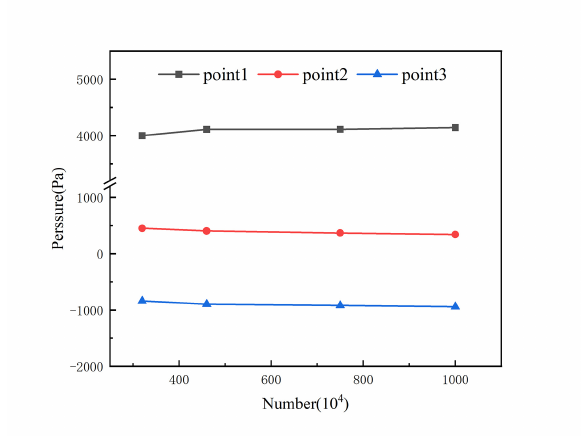
Fig. 5. Mesh irrelevance verification.